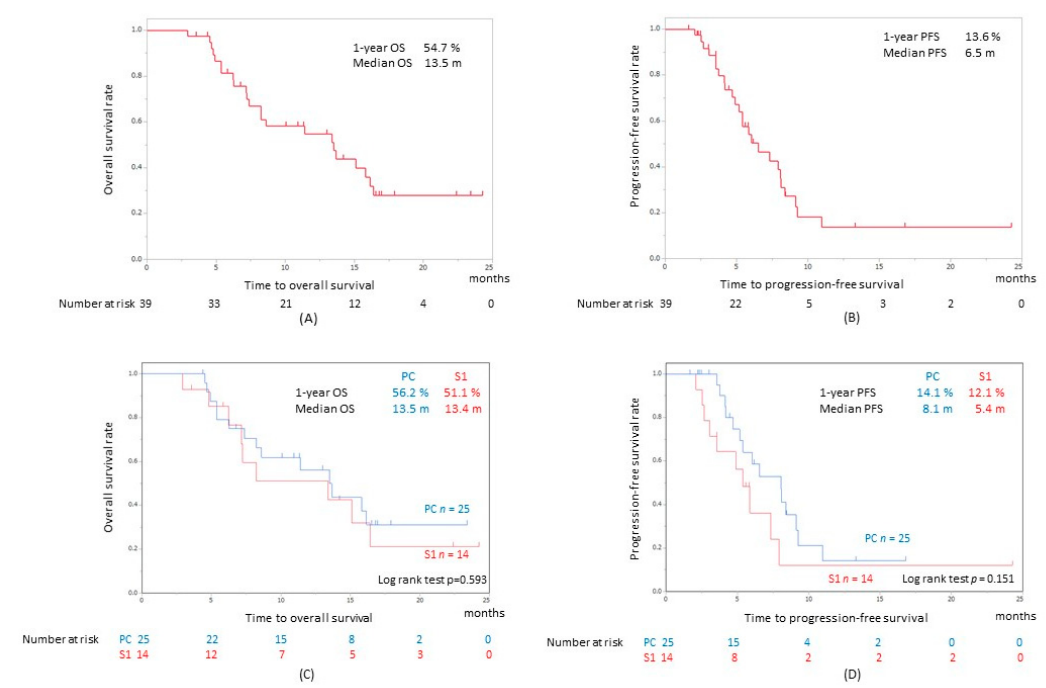
Figure 2. Kaplan-Meier curves for ( A ) OS and ( B ) PFS in all R / M HNSCC patients after SCT following nivolumab. The overall survival ( C ) and the progression free survival ( D ) between the patients administered PC and S1. OS, overall survival; PFS, progression free survival; PC, combination chemotherapy of weekly paclitaxel and cetuximab; S1, tegafur-gimestat-otastat potassium.